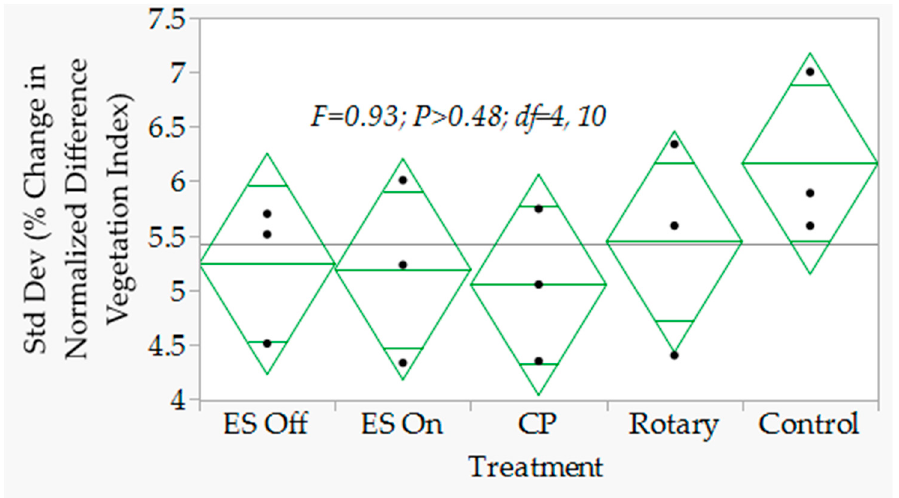
Figure 5. Mean standard deviation of percent change in NDVI averaged by replication and treatment. The middle line within each diamond is the group mean with the vertical point forming the 95% CIs. The center line is the grand mean for the response variable. The treatments described on the X -axis are electrostatically charged off (ES Off) and charged on (ES On) nozzles, the conventional hydraulic (CP) nozzle, and the rotary atomizer (Rotary) nozzle, compared with the Control.